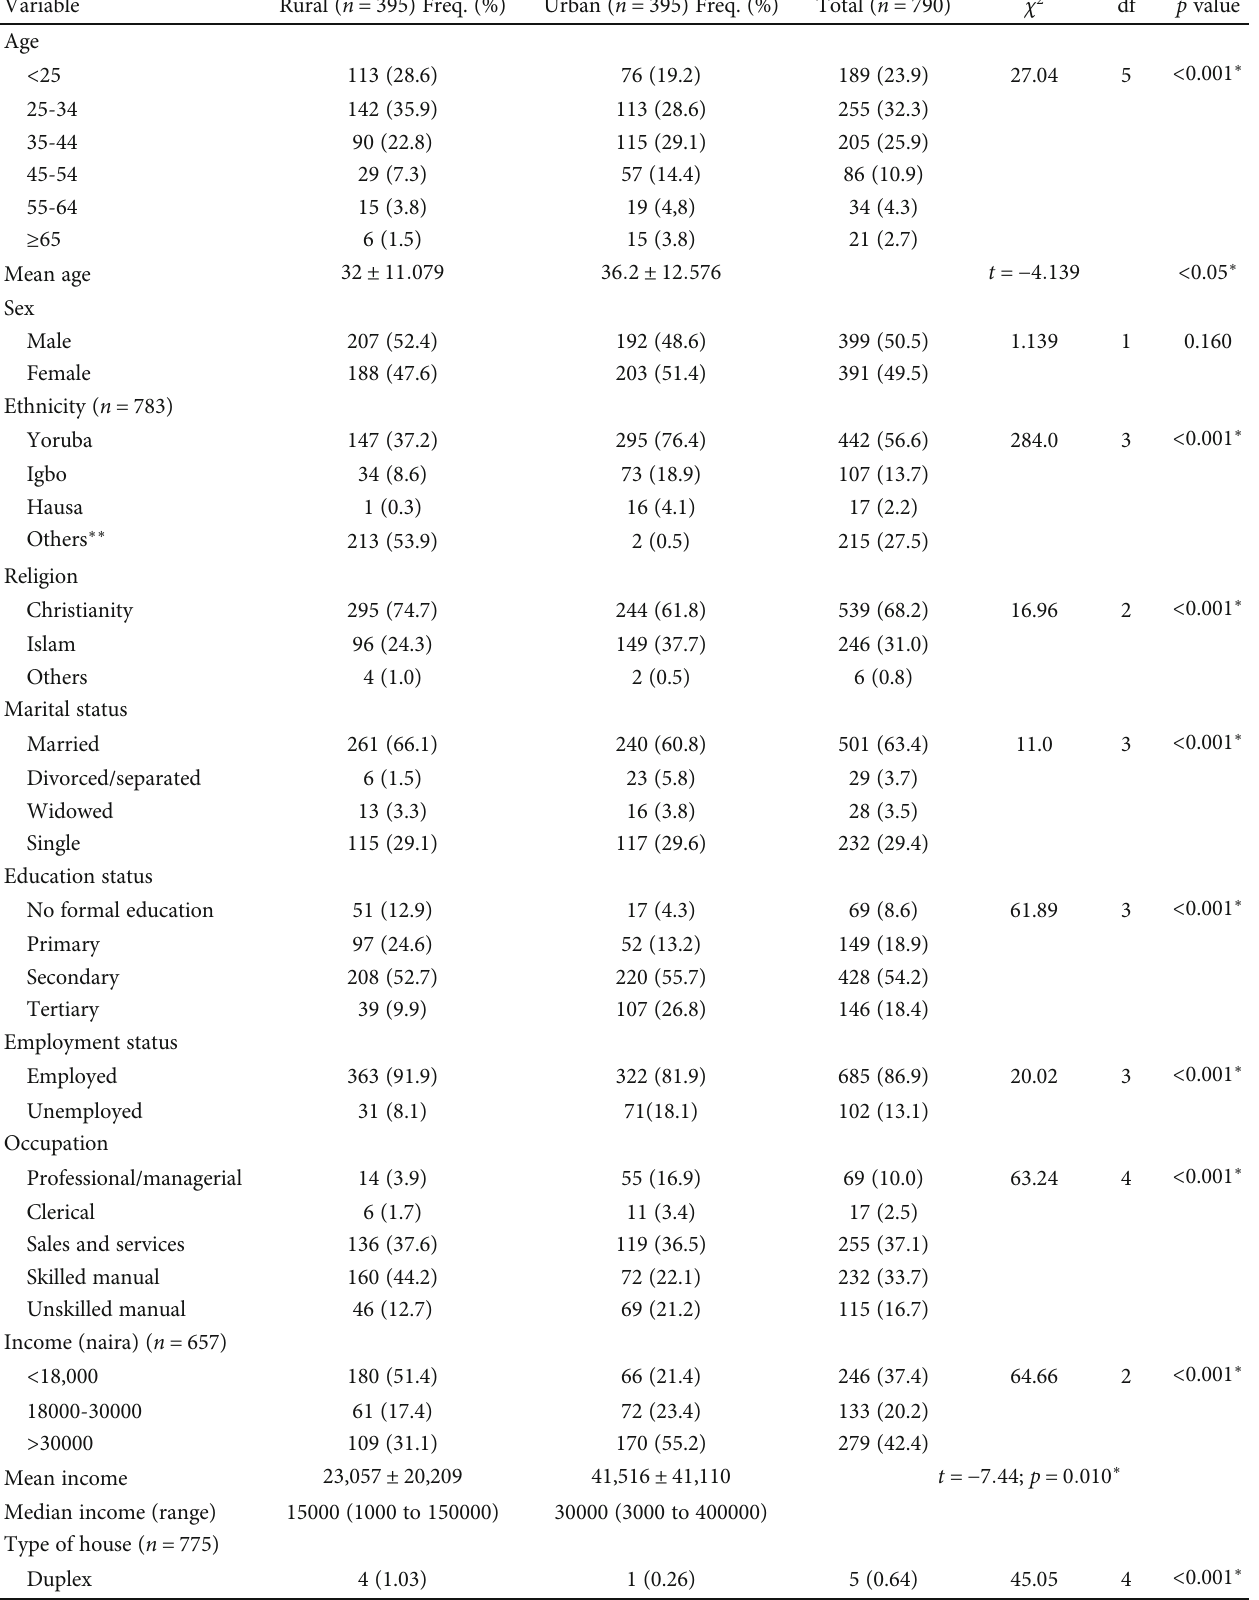
Table 1: Sociodemographic characteristics of